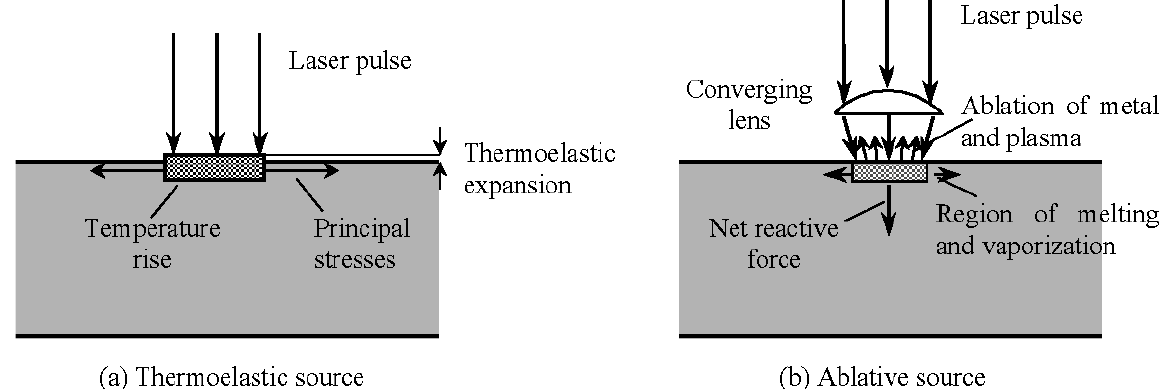
Figure 6. Thermoelastic (a) and ablative (b) phenomena in UL [57].